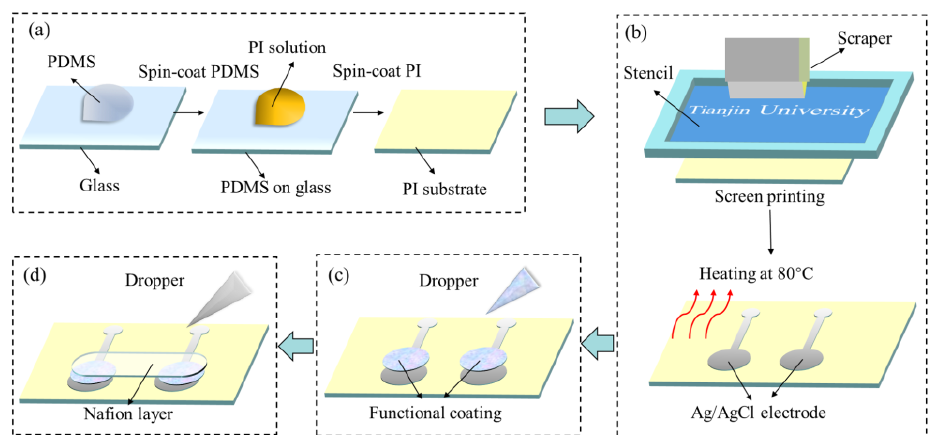
Figure 2. ( a ) Schematic diagram of PI substrate fabrication. ( b ) Schematic diagram of electrode fab- rication. ( c ) Schematic diagram of functional layer modification. ( d ) Schematic diagram of Nafion layer modification.